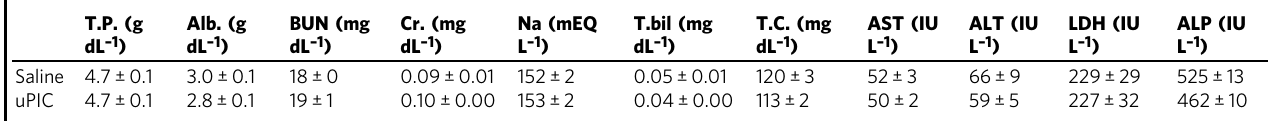
Table 1 Blood laboratory data for mice at 48 h after fi ve systemic administrations (mean ± s.e.m. n = 5)